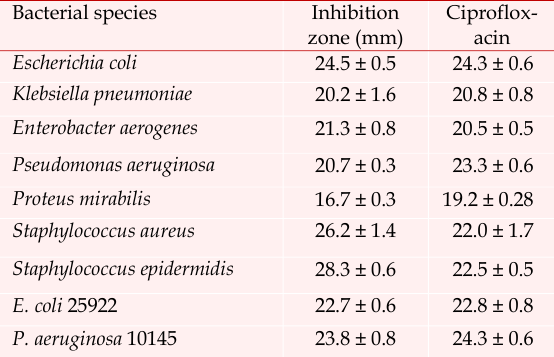
Antibacterial activity of O. ramonense EOs using disc diffusion